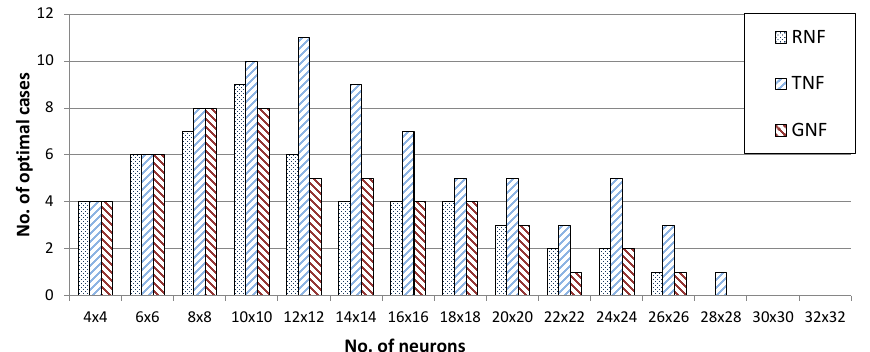
Figure 5. The number of cases (different values of R max ) for which the map becomes properly organized, for different map sizes and three neighborhood functions (RNF, TNF and